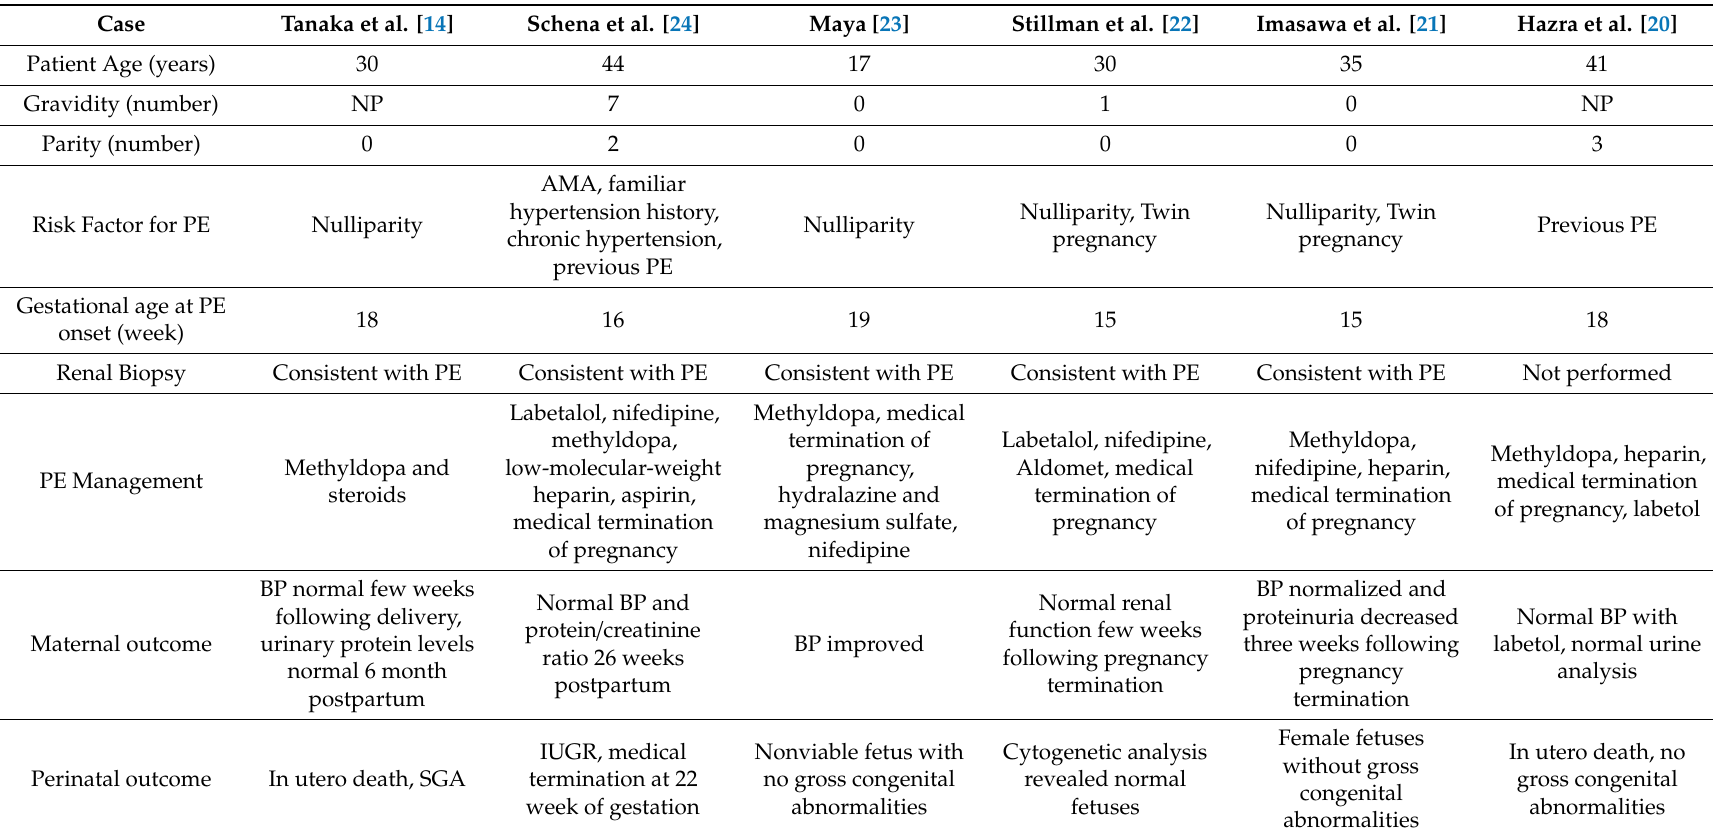
Table 1. Literature synthesis of case reports referring to early onset preeclampsia prior to the 20th week of gestation without antiphospholipid syndrome or without partial molar pregnancy with